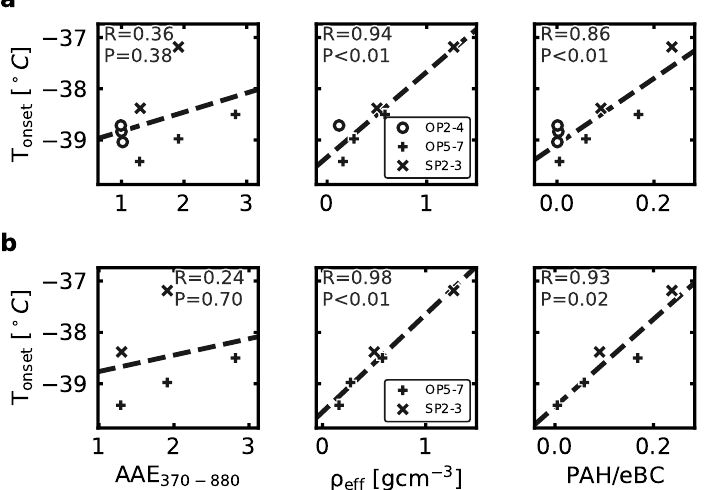
Figure 4. Pearson correlation plots for ( a ) both mature (OP2–4) and partially matured (OP5–7, SP2–3) soot particle experiments, and ( b ) partially matured soot particle experiments only (OP5–7, SP2–3), between onset temperature derived from AF ∗ = 10 − 3 data (Figure 3b) and the AAE, ρ ef f and PAH/eBC parameters examined in this study. Presented in each panel is correlation coefficient R and associated p -value. Significant correlations for ρ ef f and PAH/eBC could be seen for the full particle ensemble as well as for the partially matured soot subgroup. Distinction is made in the plots between setpoints OP2–4 marked with circles, OP5–7 marked with pluses, and SP2–3 marked with